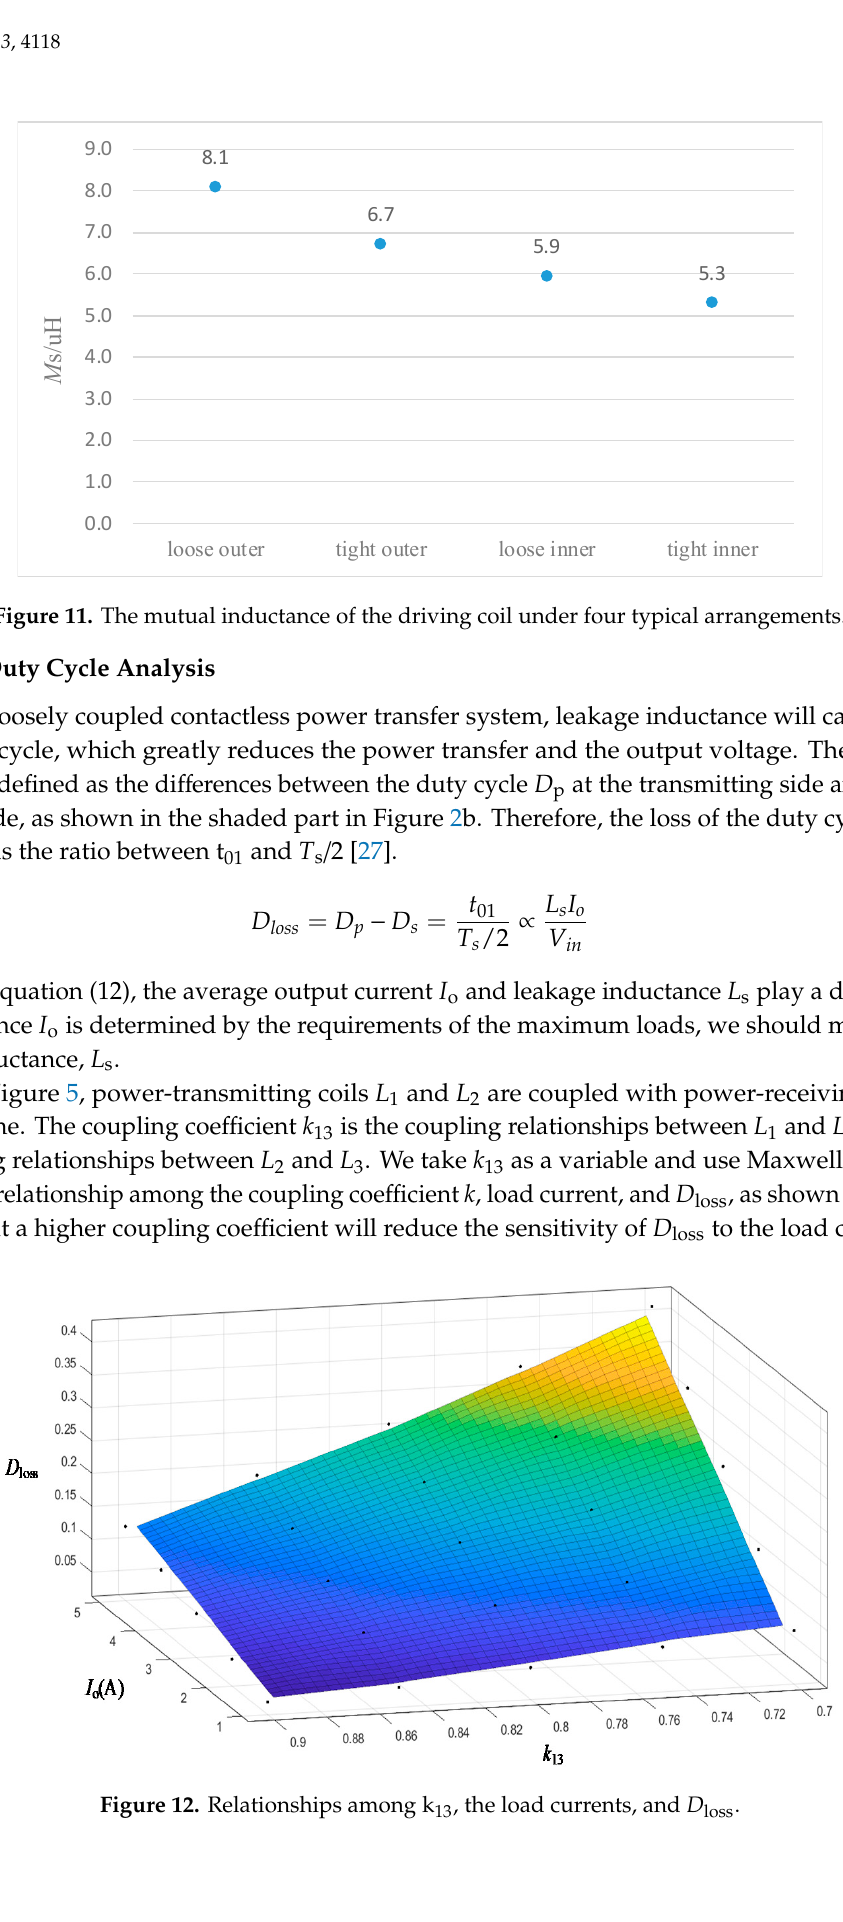
( d ) Figure 10. Typical arrangements of the driving coil: ( a ) loose outer, ( b ) tight outer, ( c ) loose inner, and ( d ) tight inner.